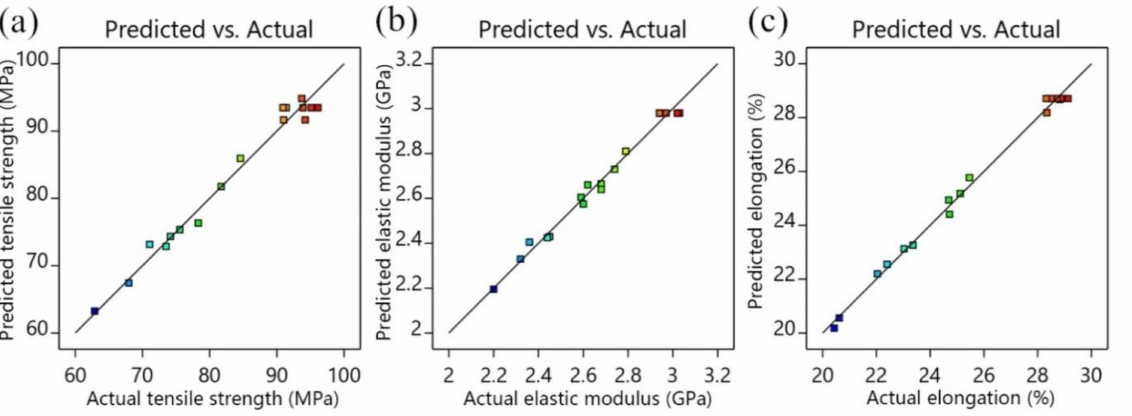
Figure 7. Linear plots: ( a ) predicted and actual values of tensile strength, ( b ) predicted and actual values of elastic modulus and ( c ) predicted and actual values of